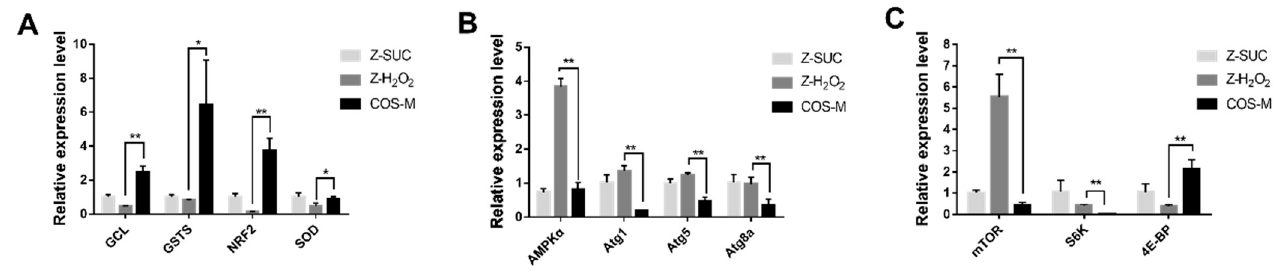
Figure 10. The relative expression levels of target genes in Z-SUC, Z-H 2 O 2 and COS-M groups. ( A ) Genes associated with antioxidant activities. ( B ) Genes relevant to autophagy. ( C ) Immune-related genes. Differences among treatments were obtained with one-way analysis of variance followed by Tukey’s multiple comparisons test. * and ** represent p < 0.05 and p < 0.01